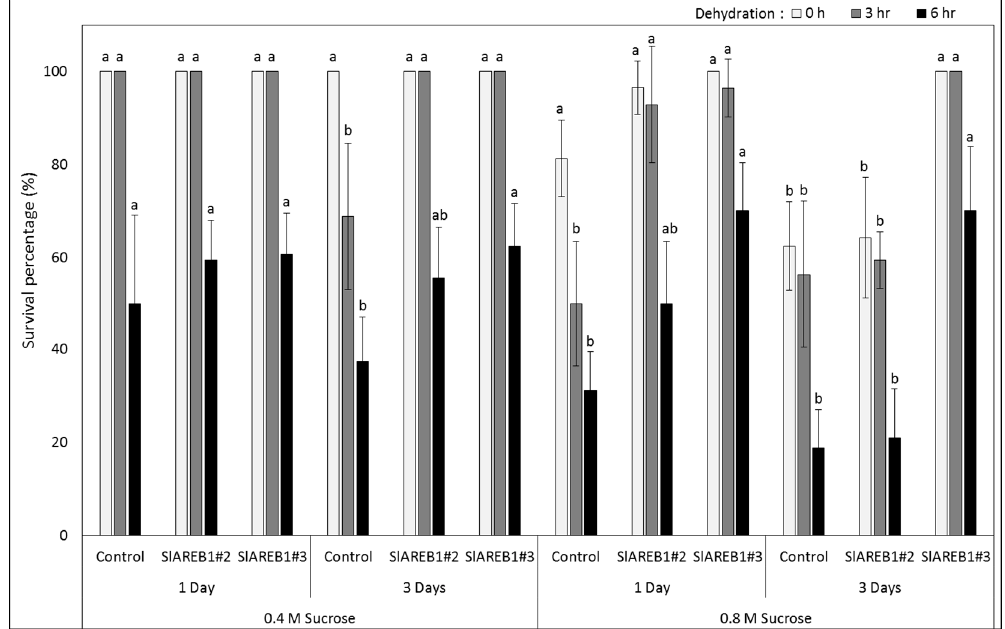
Figure 2. Survival percentages of encapsulated-dehydrated shoot tips of non-cryopreserved shoots tips ( − LN) of negative control, SlAREB1#2 and SlAREB1#3 transgenic tomato plants as affected by air dehydration duration after pretreatment with 0.4 and 0.8 M sucrose concentration for one or three days (values are the mean ± SD). Based on Tukey’s HSD test, different letter indicates significant difference among transgenic lines ( p < 0.05) for each combination of sucrose concentration, number of days, and air dehydration duration.